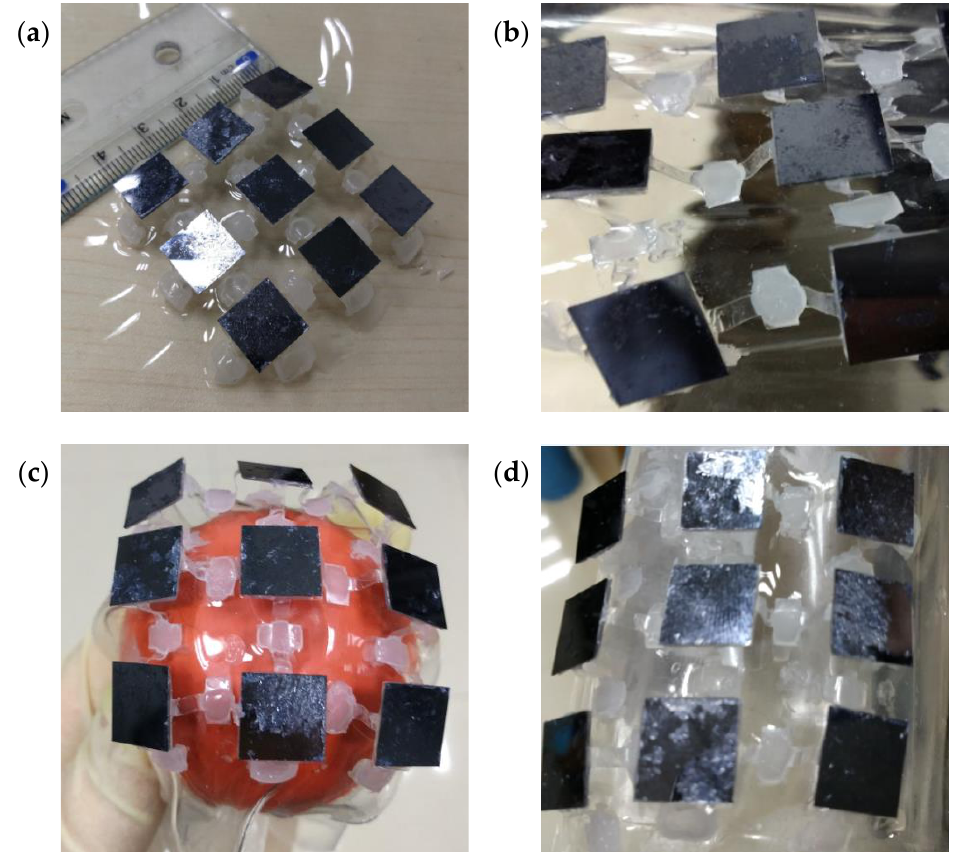
Figure 8. Experiments about solar array structures: ( a ) the initial structure; ( b ) stretching to 40%; deform conformably to ( c ) spherical and ( d ) cylindrical surfaces, respectively.